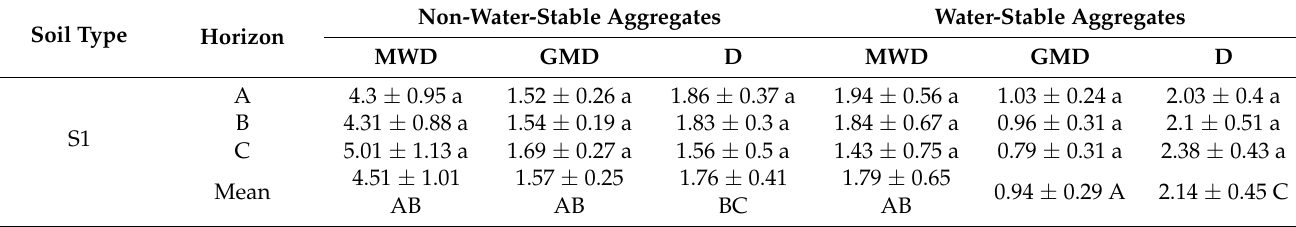
Table 3. Variance analysis of non-water- and water-stable aggregates (mean and sd) of mean weight diameter (MWD), geometric mean diameter (GMD), and fractal dimensions (D) in 6 soil types (subalpine meadow soil, S1; meadow soil, S2; dark brown soil, S3; brown soil, S4; yellow-brown soil, S5; and cinnamon soil, S6). The different uppercase letters indicate significant difference at p < 0.05 by LSD test among 6 soil types, and the same letters indicate no significant differences at p < 0.05 by LSD test among 6 soil types. The different lowercase letters indicate significant difference at p < 0.05 by LSD test among 3 horizons (leaching horizon, A; sediment horizon, B; and parent material horizon, C) in the same soil types, and the same letters indicate no significant differences at p < 0.05 by LSD test among 3 horizons in the same soil